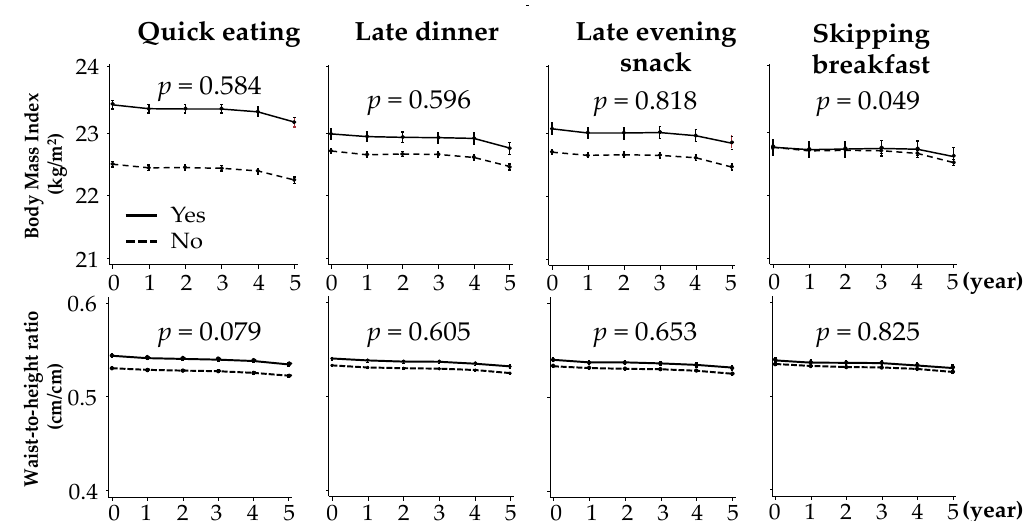
Figure 2. Changes in body mass index and waist-to-height ratio according to baseline unhealthy dietary habits. Adjusted for age, sex, body mass index, systolic blood pressure, estimated glomerular filtration rate, hemoglobin, triglyceride, total cholesterol, HbA1c, serum uric acid, daily drinking, and current smoking. Error bars represent the 95% confidence interval.